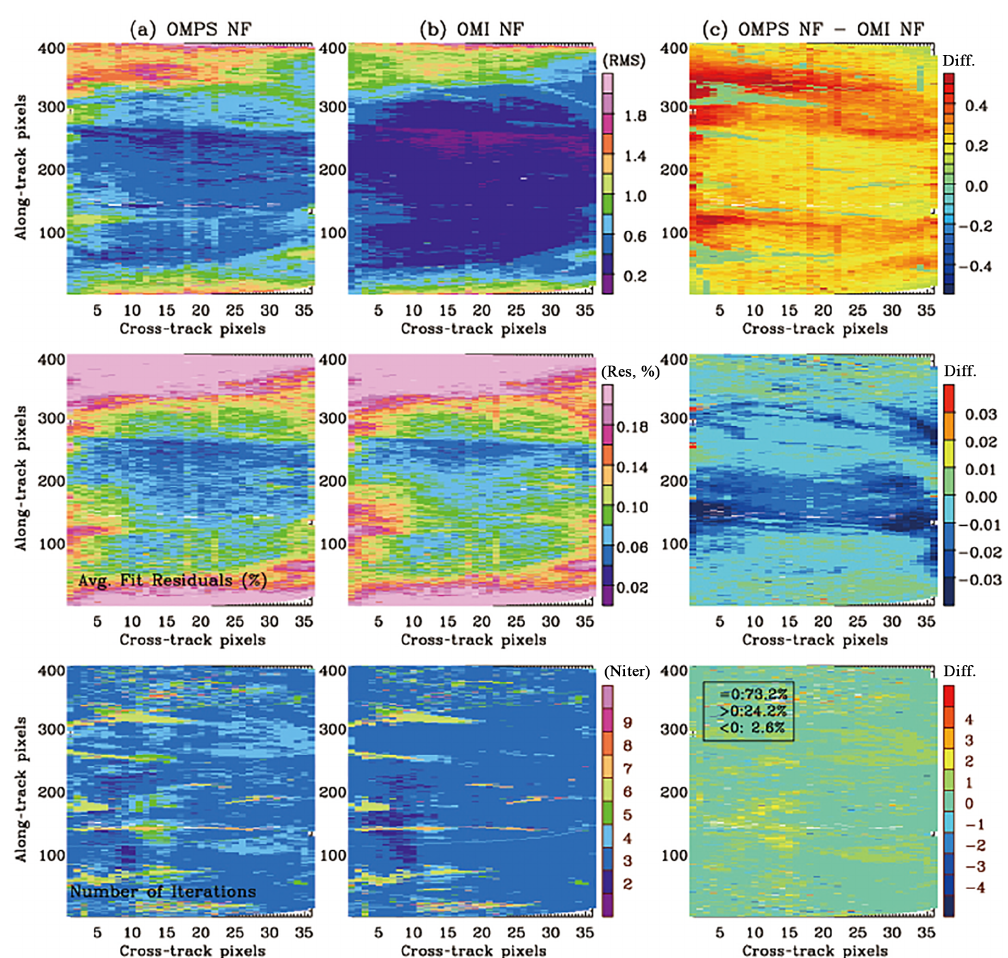
Figure 13. Top: comparison of rms of fitting residuals relative to the assumed measurement errors as functions of cross-track and along-track pixels for orbit 7132 with (a) OMPS NF (first column) and (b) OMI NF (second column), respectively, with (c) their absolute differences (third column). The definition of rms is given in Fig. 11. Middle: comparison of average fitting residuals relative to the simulated radiances (%), which are similar to rms, except that radiance differences are normalized to measured radiances instead of measurement errors. Bottom: comparison of the number of the retrieval